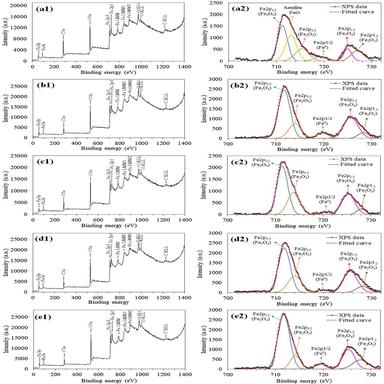
Wide-scan (left column) and Fe2p narrow-scan (right column) XPS spectrums for (a1, a2) BC/nZVI, (b1, b2) 6HBC/nZVI, (c1, c2) 8HBC/nZVI, (d1, d2) 12HBC/nZVI, and (e1, e2) 24HBC/nZVI samples, all synthesized under the optimized conditions.